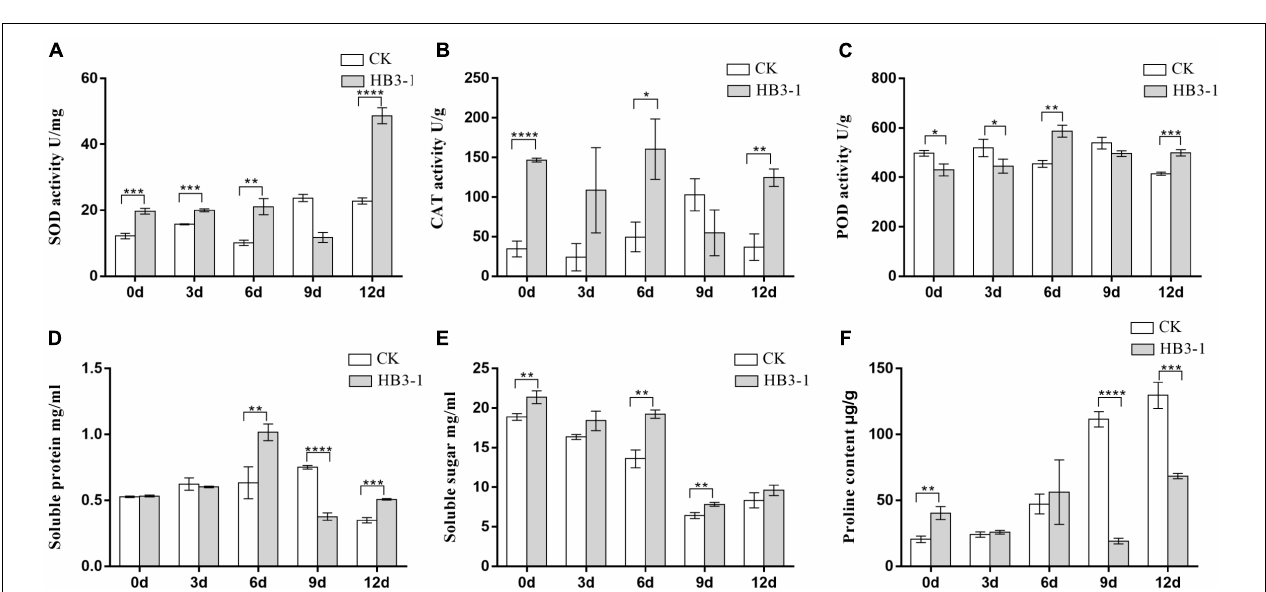
FIGURE 5 | Differences in physiological variables between control (CK) seedlings and seedlings inoculated with dark septate fungal endophyte strain HB3-1. (A) Superoxide dismutase (SOD) activity. (B) Catalase (CAT) activity. (C) Peroxidase (POD) activity. (D) Soluble protein content. (E) Soluble sugar content. (F) Proline (PRO) content. * P < 0.05, ** 0.001 ≤ P < 0.01, *** 0.0001 ≤ P < 0.001, **** P <